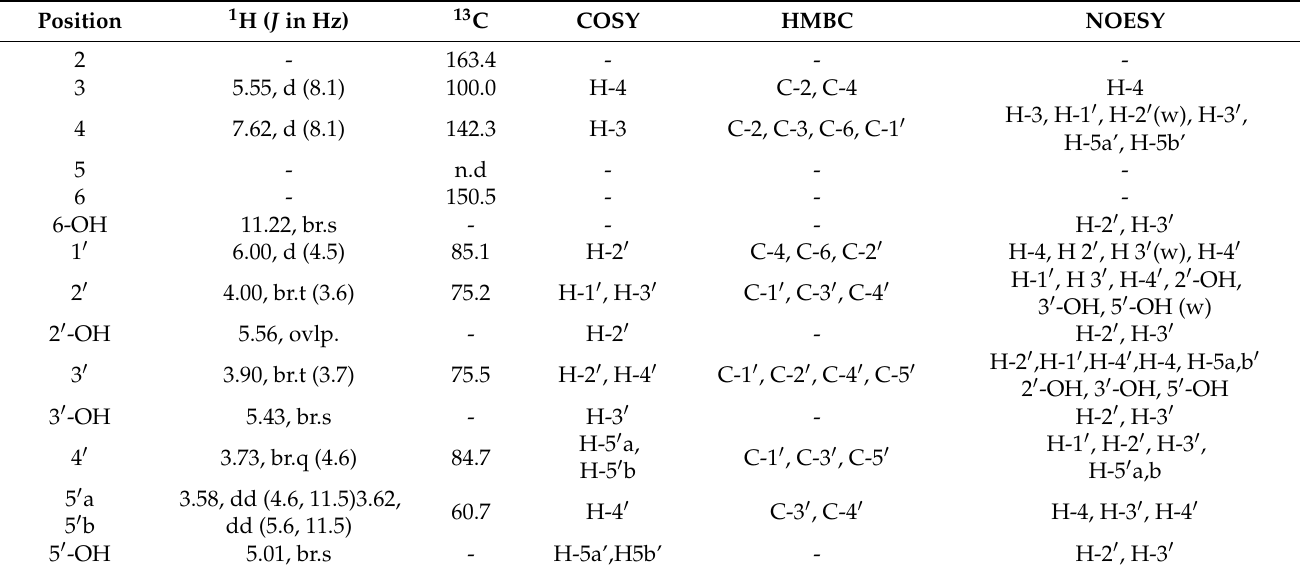
Table 1. NMR data of 1 (600 MHz, DMSO- d 6 , δ ppm) a,b .